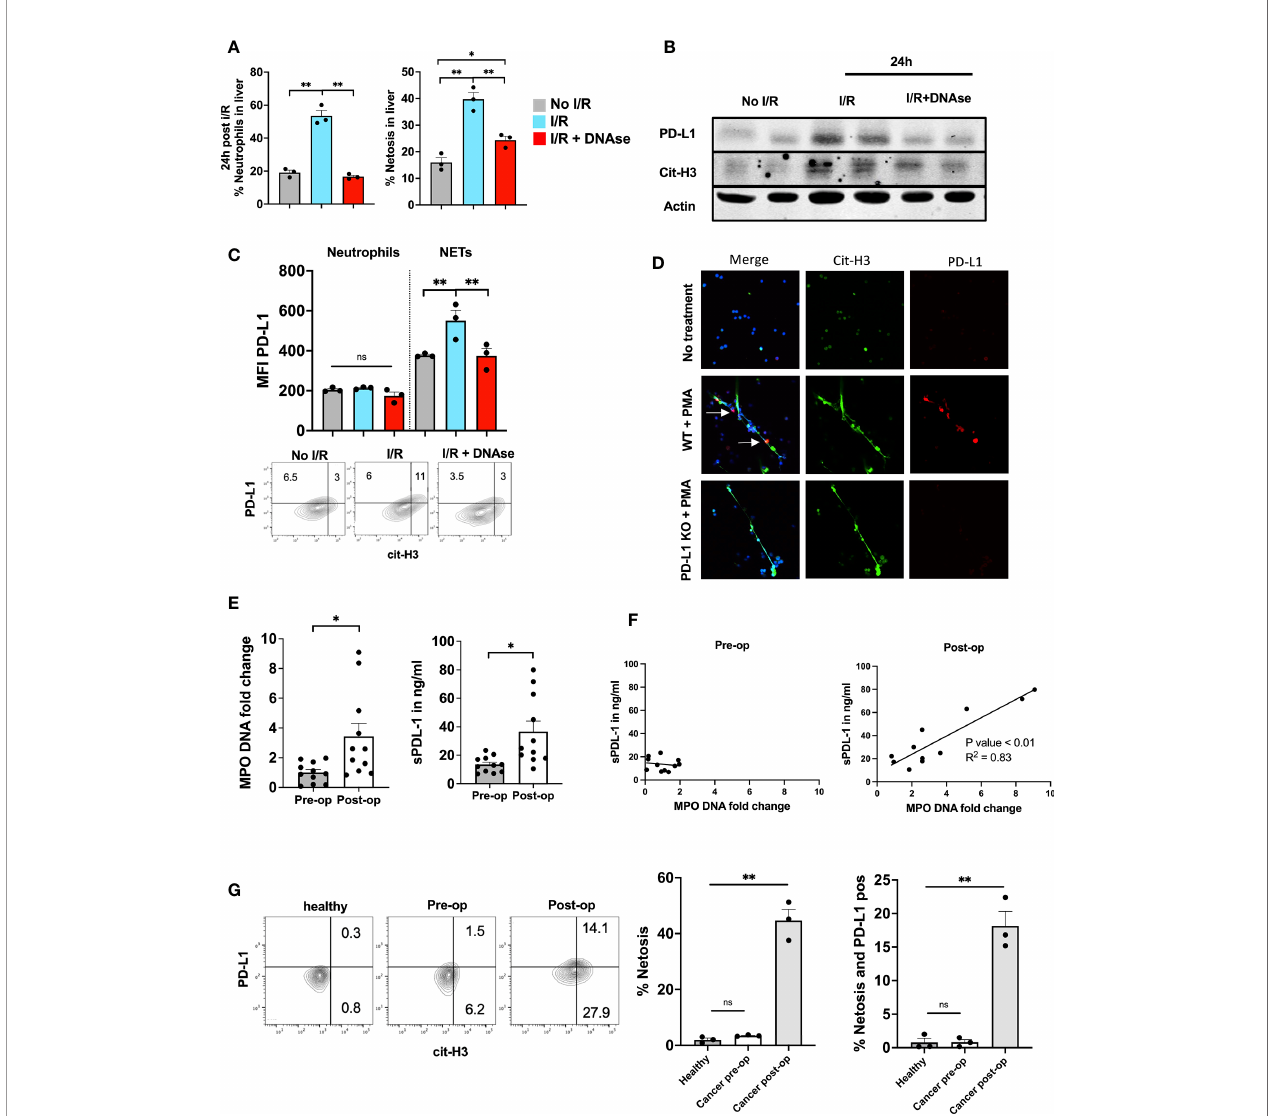
FIGURE 5 | PD-L1 is embedded inside NET chromatin. (A) 8-week-old B6 mice underwent liver I/R without tumor injection followed by harvest of the ischemic lobe at 24h. Tissue was analyzed by fl ow cytometry for the presence of neutrophils and netosis. The ischemic lobe was extensively in fi ltrated by neutrophils and NETs unless DNAse was administered. (B) Western blot of ischemic lobes was performed showing increased levels of PD-L1 and cit-H3 in mice that underwent liver I/R This effect was reversed by treatment with DNAse. (C) Neutrophils within the ischemic lobe were stained for PD-L1 or PD-L1 and cit-H3. (D) Immuno fl uorescence staining shows that treatment of normal WT bone marrow derived neutrophils with PMA leads to the upregulation of PD-L1 within the extruded NET chromatin; however, no PD-L1 expression was found in PD-L1 KO NETs. Flow cytometry of isolated WT bone marrow derived Neutrophils stained with cit-H3 and PD-L1 are shown. (E) Patient serum levels of both MPO-DNA and sPD-L1 were elevated in the fi rst post-operative days after hepatic resection. (F) MPO-DNA and sPD-L1 levels were correlated pre-/and postoperative. (G) Whole blood from healthy individuals or patients undergoing surgery was stained for the presence of neutrophil forming NETs. A greater percentage of NET forming neutrophils was found in patients on post-operative day 1 compared to pre-operative and healthy individuals. Similarly, more NETs were present and expressed PD-L1 in the post-operative patient. (n=3) Flow cytometry plots are representative of one experiment. Bar graphs represent mean +/- SEM of two independent experiments. MPO-DNA/s-PD-L1 levels (E, F) were derived from eleven healthy or postoperative patients. (G) three healthy or postoperative patients were analyzed for neutrophil NET markers and surface PD-L1 expression. *p < 0.05, **p <